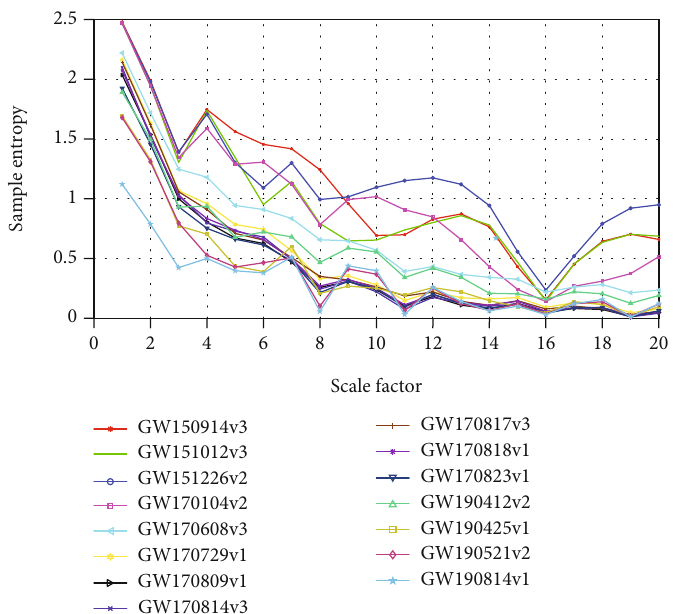
Figure 2: MSE analysis of the GW interval data recorded by L1 observatory.